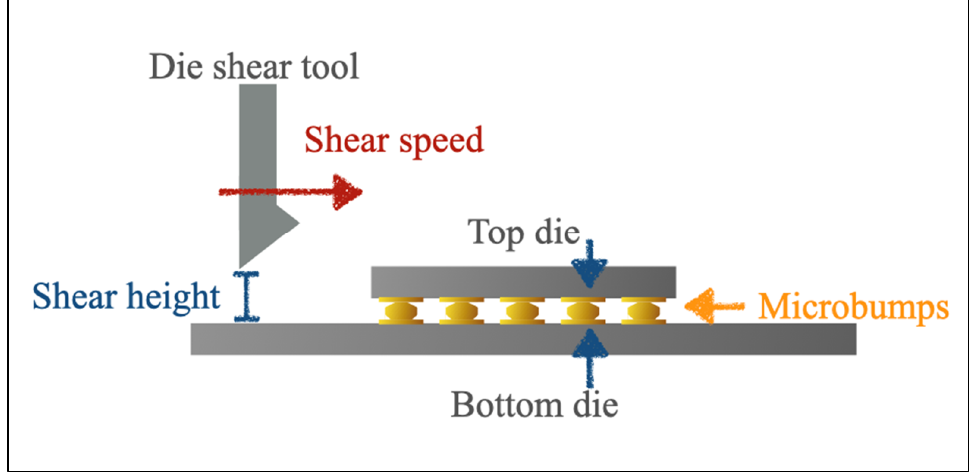
Figure 12. Schematic of die shear test. Shear height was set at 200 µm and the shear speed was set at 100 µm/s.